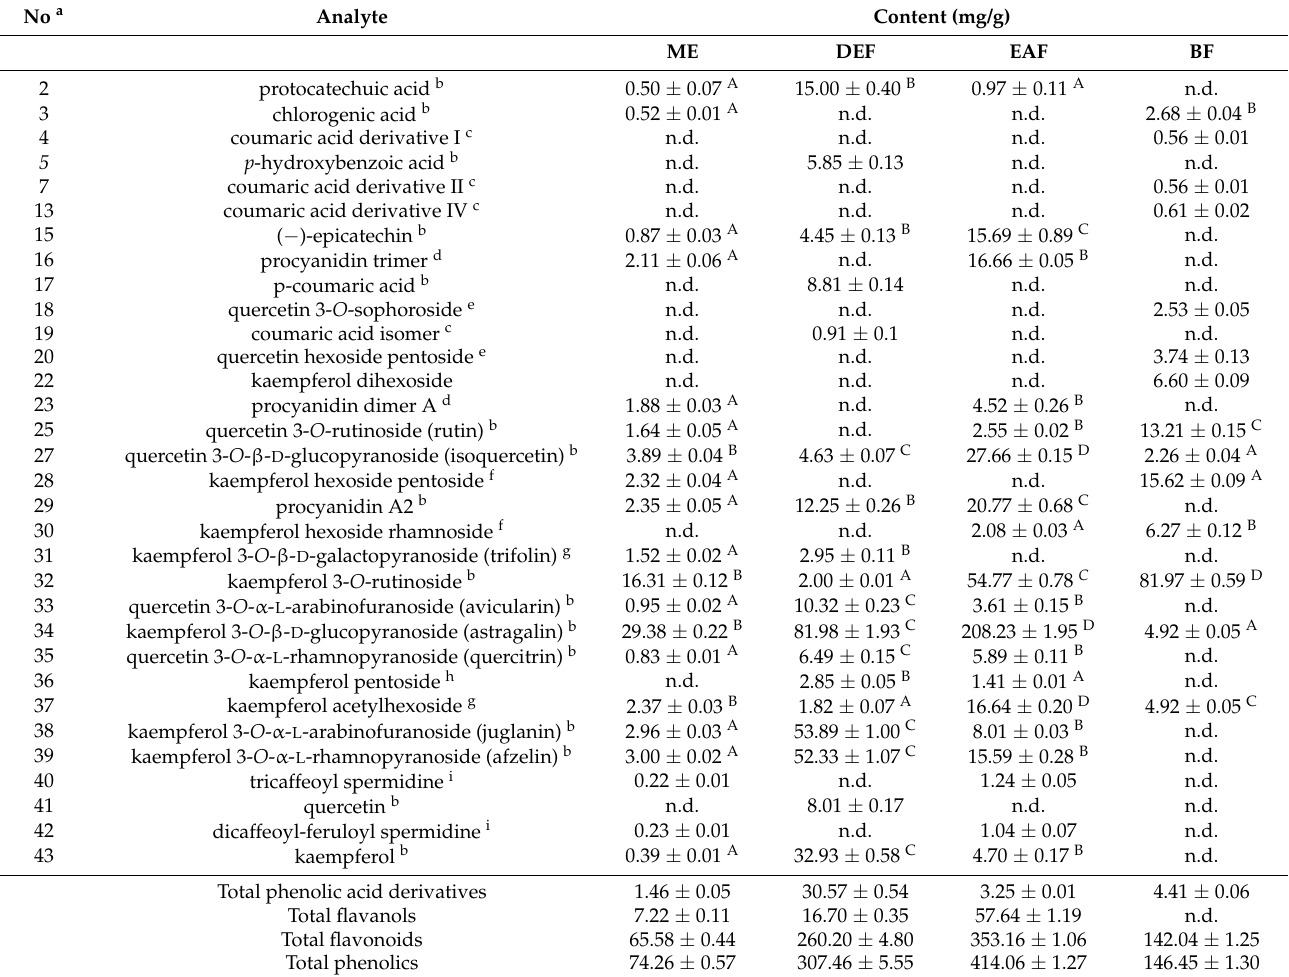
about 1:8 and kaempferol 3-rutinoside as the dominant constituent (81.97 mg/g, 56% of the fraction). Table 2. Content of the major polyphenols in the dry extracts from the flower of A. hippocastanum